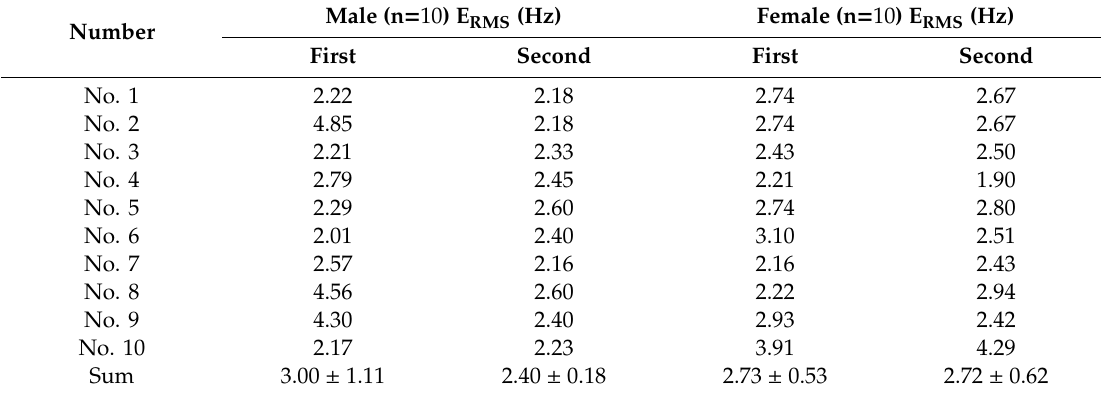
Table 2. All E RMS values between the real-time MF value and the o ff -line MF values for the twenty subjects.